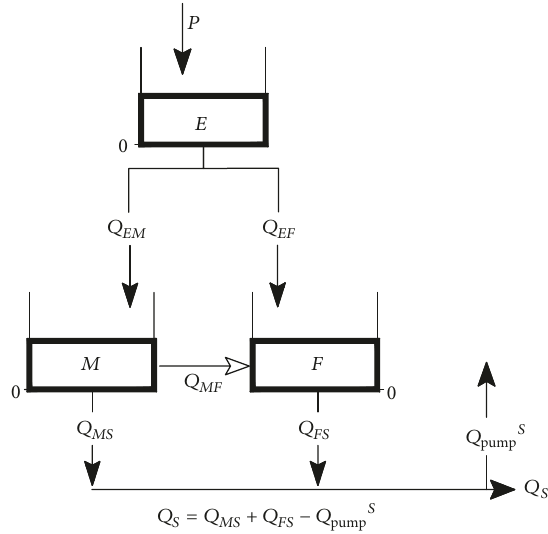
Figure 6: Structure of the model